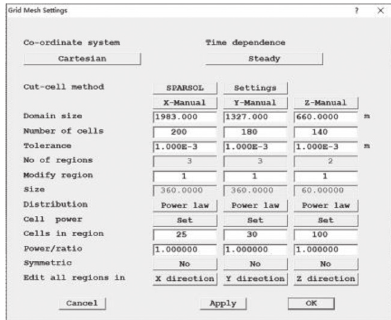
Figure 7: The grid setting of X , Y , and Z axis of the CUMTB